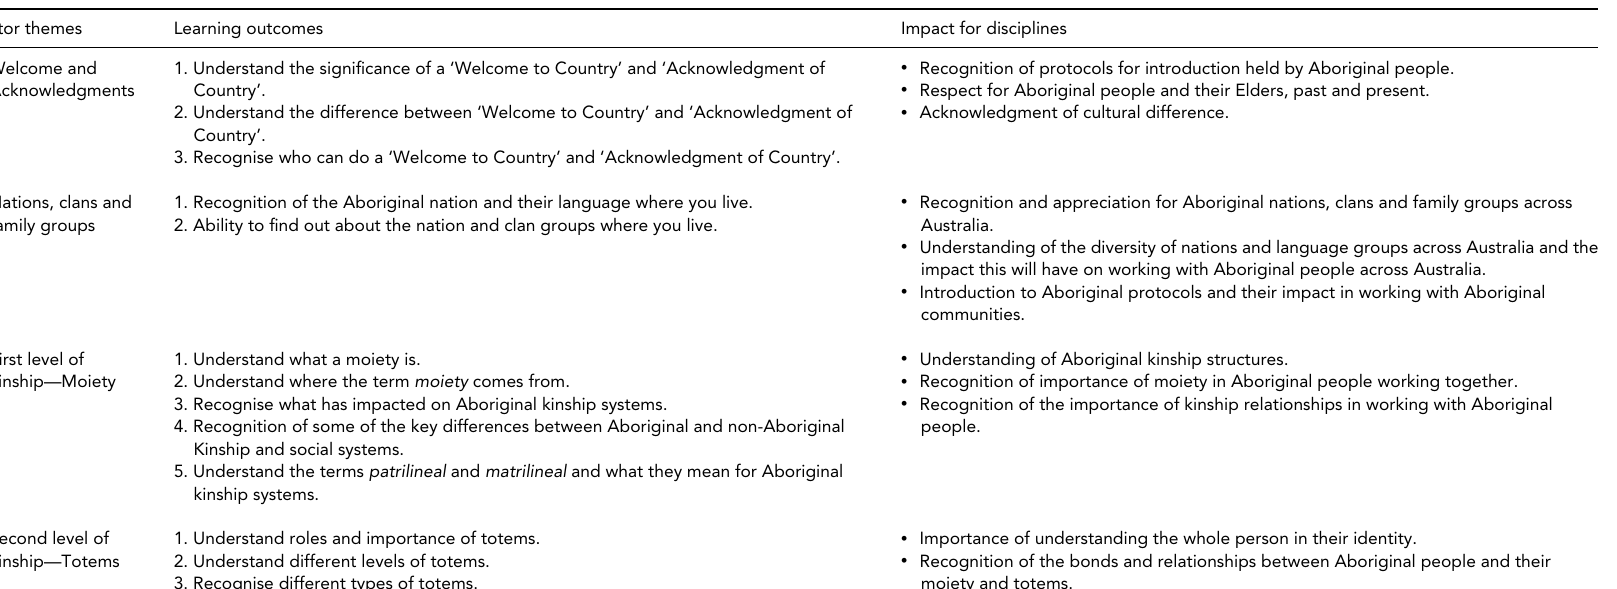
TABLE 1 Kinship Module: Sector Themes, Learning Outcomes and Impact for